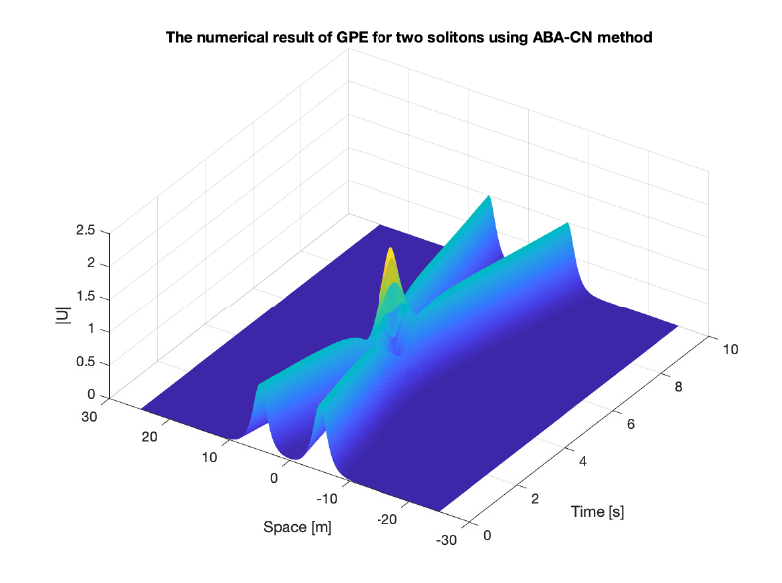
Figure 3. Solution of the ABA-CN method for the two